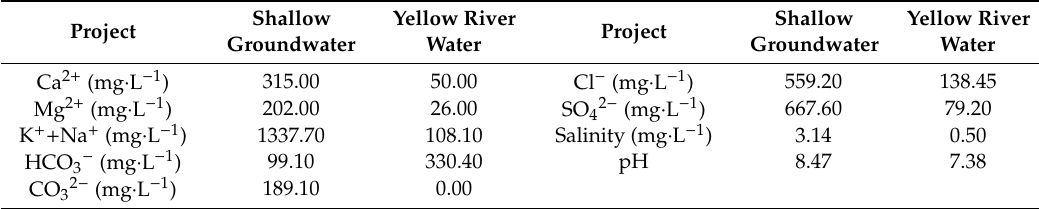
Figure 3. The precipitation during sunflower growth period. ( a ) Precipitation during sunflower growth period in 2016; ( b ) Precipitation during sunflower growth period in 2017. Table 3. The main compositions and features of water.